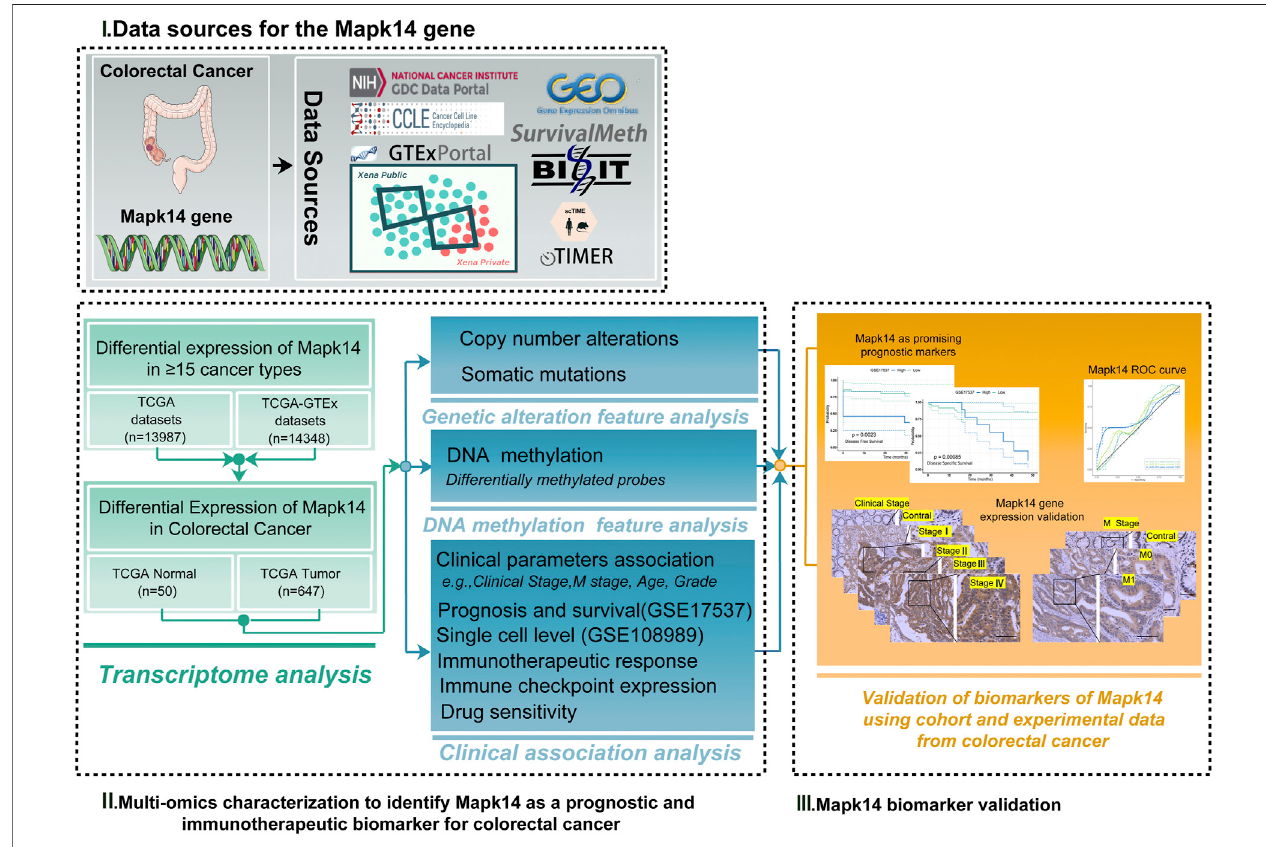
FIGURE 1 | Analytical fl owchart of this study. First, we explored the differential expression ofMapk14 in ≥ 16 tumor types. Then the multi-omic pro fi le ofMapk14 in colorectal cancer was analyzed, and we identi fi ed Mapk14 as a prognostic and biomarker for colorectal cancer. Finally, we investigated the functional signi fi cance of Mapk14 in CRC and validated the Mapk14 biomarker using IHC experimental